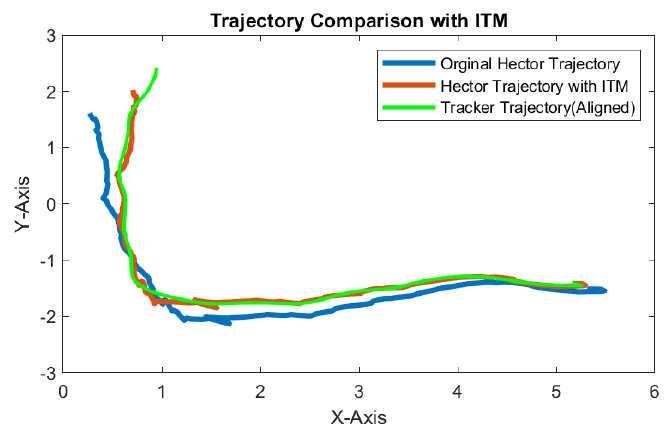
Figure 7. Zoom-in on the section of trajectories in the active ITM process.